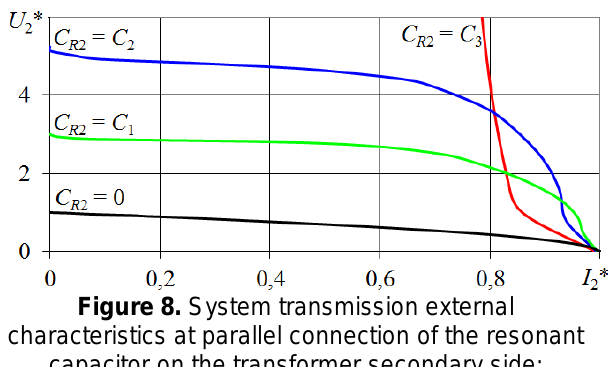
Figure 8. System transmission external characteristics at parallel connection of the resonant capacitor on the transformer secondary side: < C C < C 3 1 2